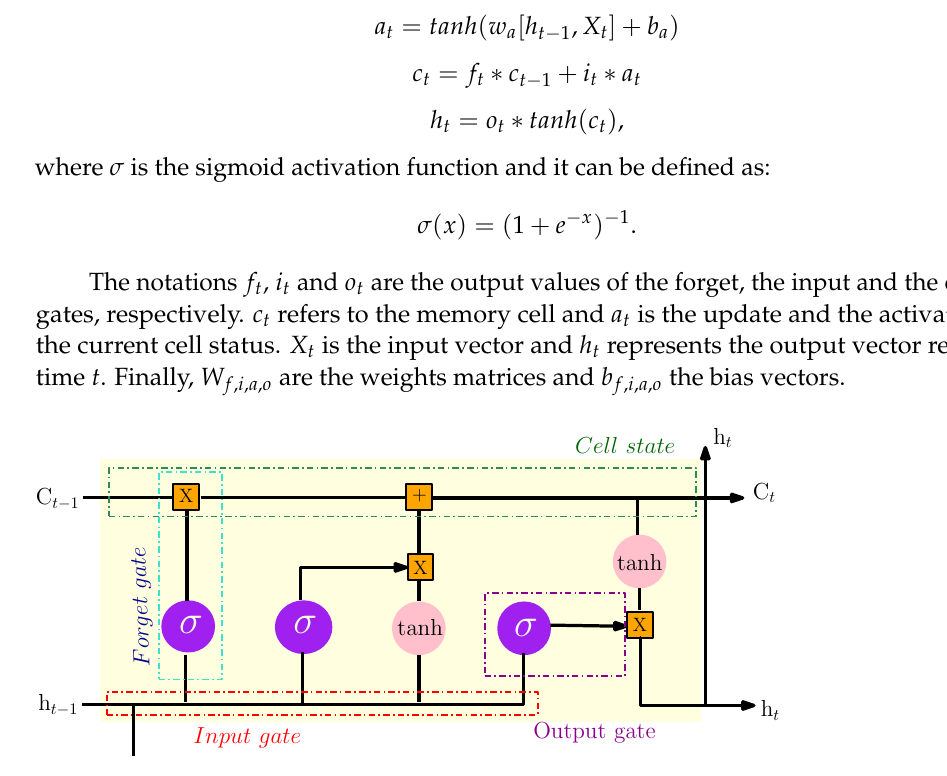
Figure 5. The internal structure of the LSTM